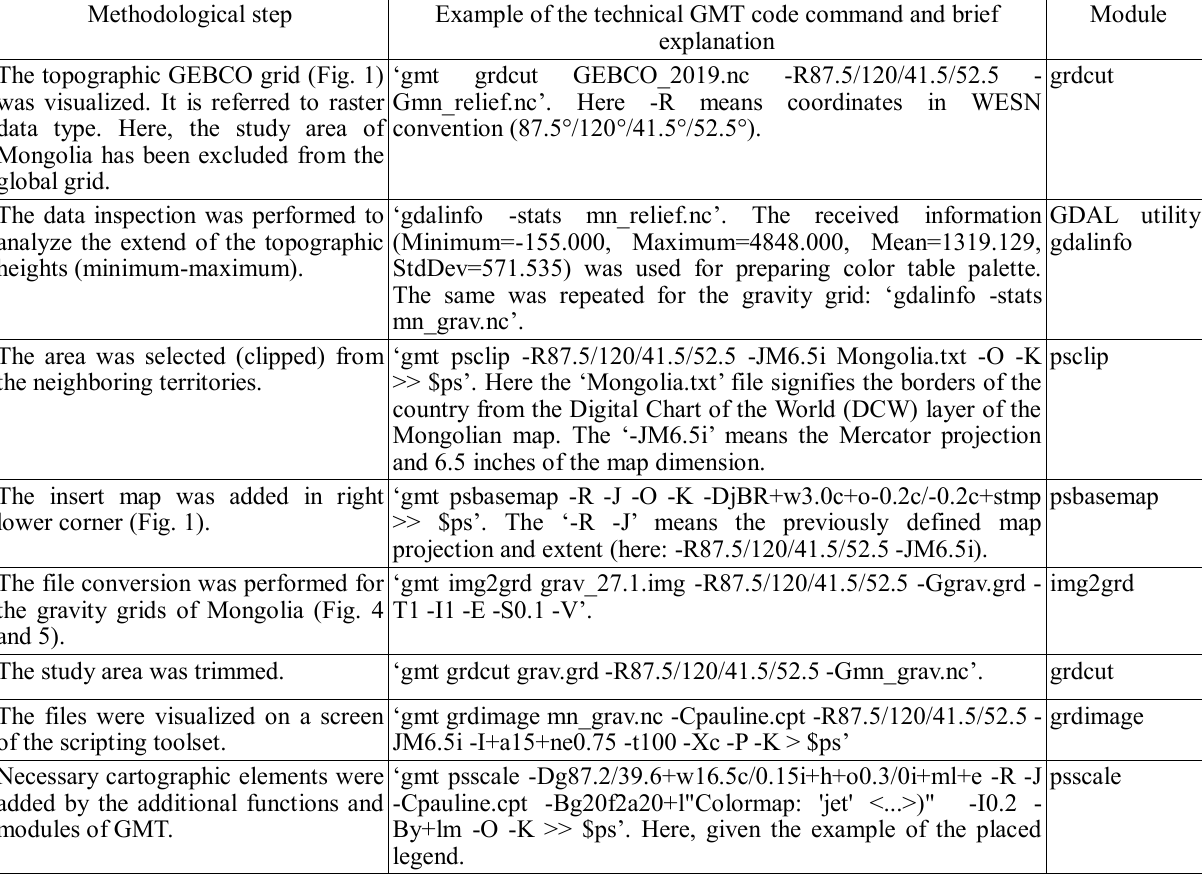
Table 1. Methodological workflow in